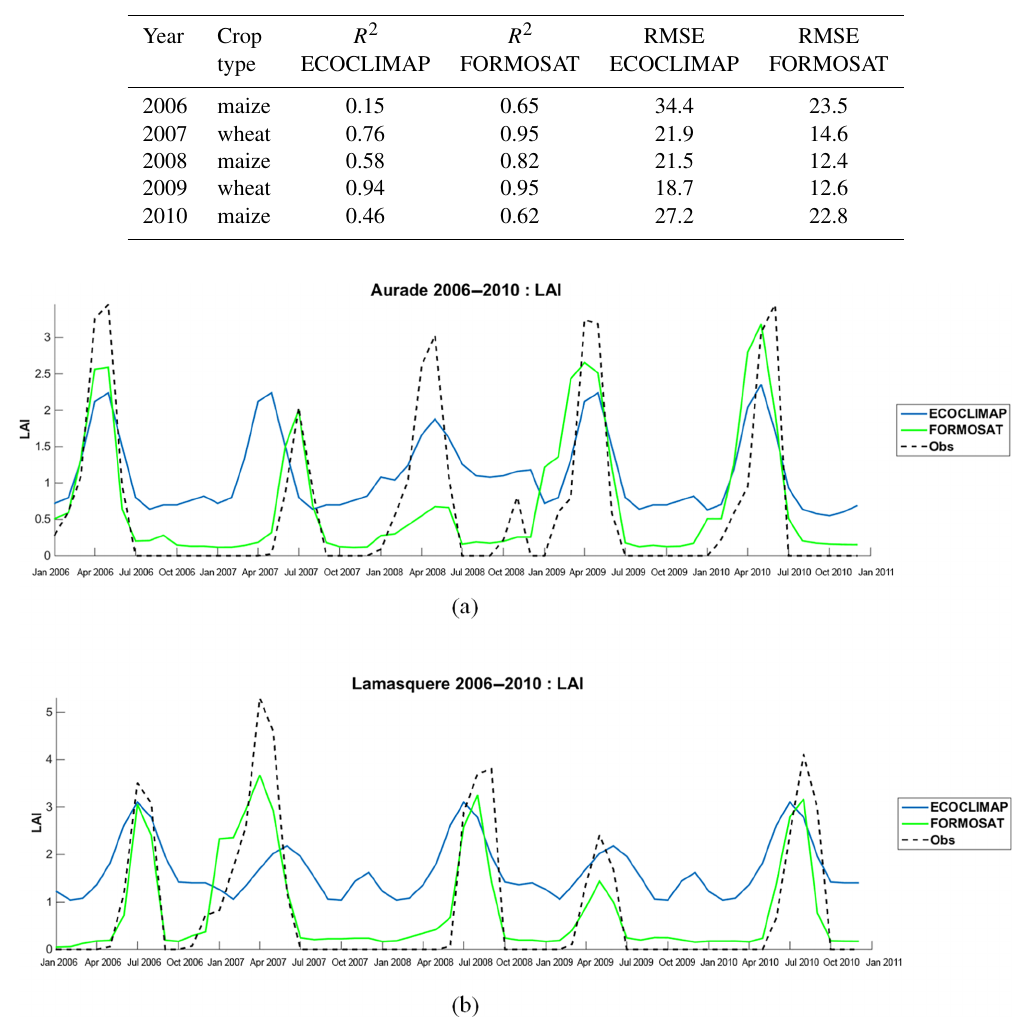
Figure 5. LAI time series for Auradé (a) and Lamasquère (b) for 2006 to 2010. The crop type for each year is described in Tables 2 and 3.